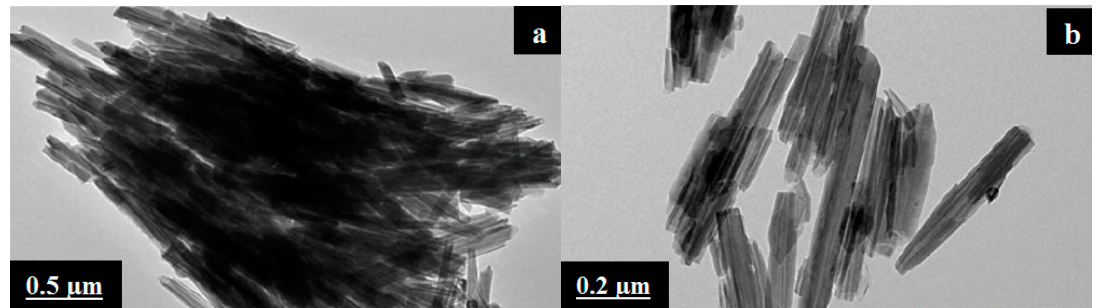
Figure 7. TEM images of HNTs: ( a ) untreated and ( b ) after acid treatment [7].